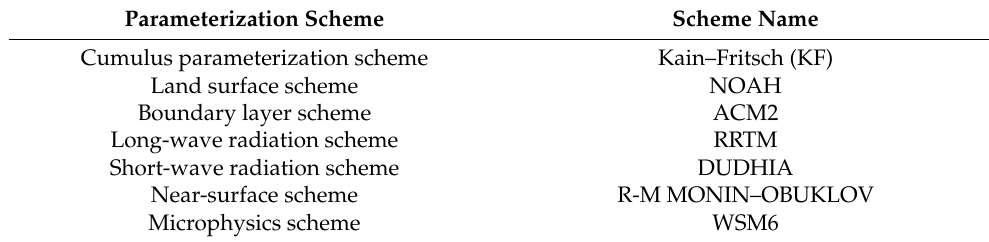
Table 1. Parameterization scheme of WRF model for the simulation of Gobi grassland wind